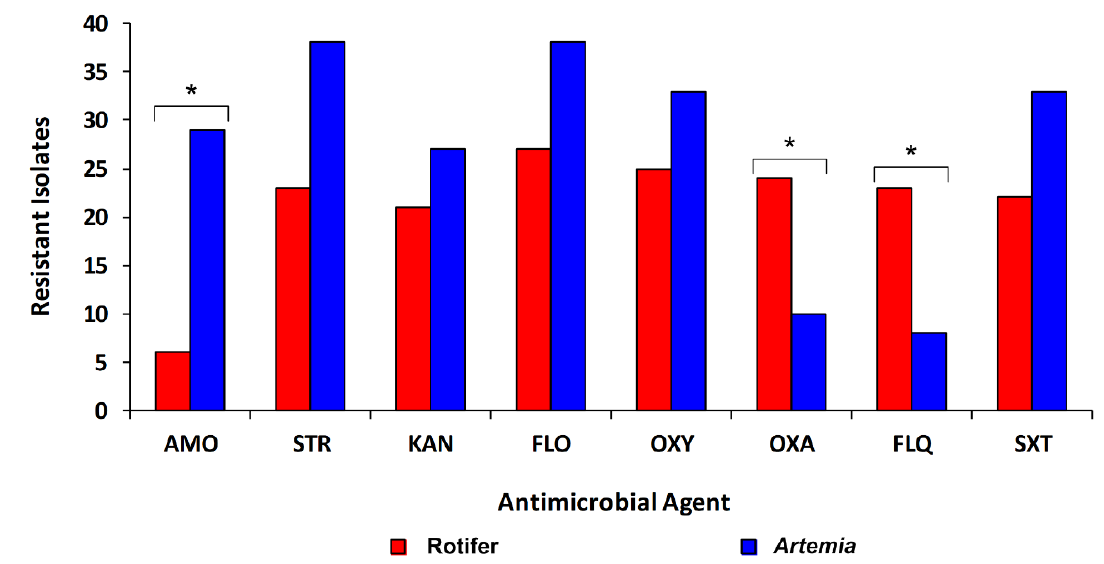
Figure 3. Antibacterial resistance of studied bacterial isolates recovered from rotifer (n = 27) and Artemia (n = 38) cultures used to feed Genypterus chilensis larvae. AMO: Amoxicillin; STR: Streptomycin; KAN: Kanamycin; FLO: Florfenicol; OXY: Oxytetracycline; OXA: Oxolinic acid; FLQ: Flumequine; SXT: Sulfamethoxazole-trimethoprim. * Significant difference ( p < 0.05) between rotifer and Artemia cultures.